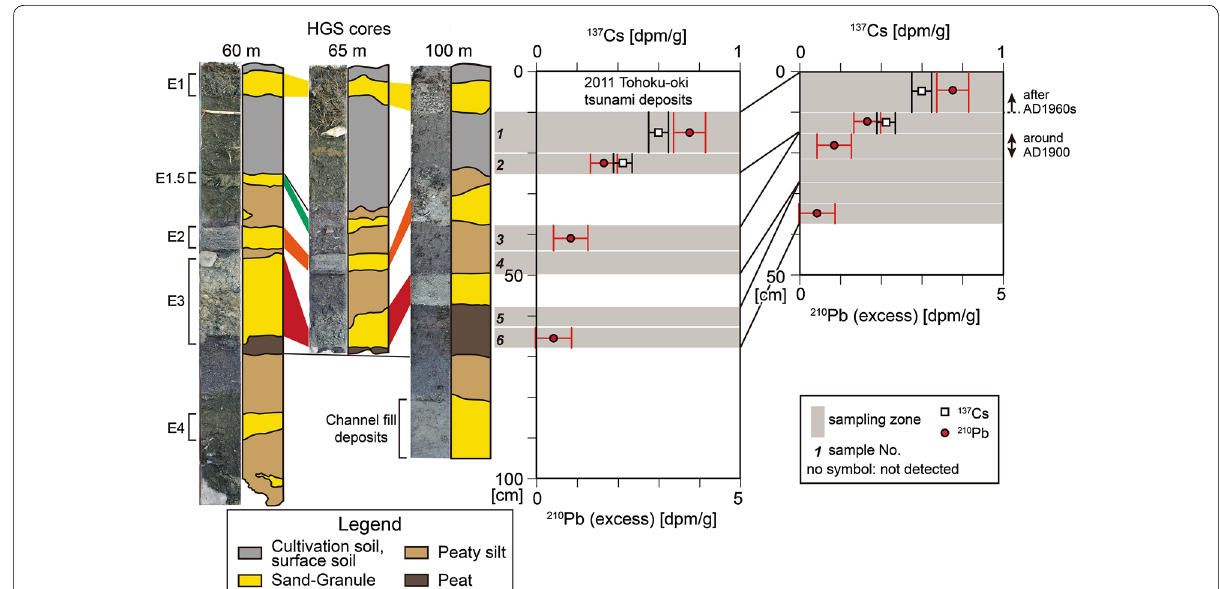
Fig. 3 Sketches of HGS cores at 60, 65, and 100 m and results of 134 Cs and excess 210 Pb measurements. Locations of the HGS cores are shown in Fig. 1. The sketches were modified after Ishimura et al. (2015), and all sketches of the HGS cores and subsurface profile are shown in Additional file 2: Figure